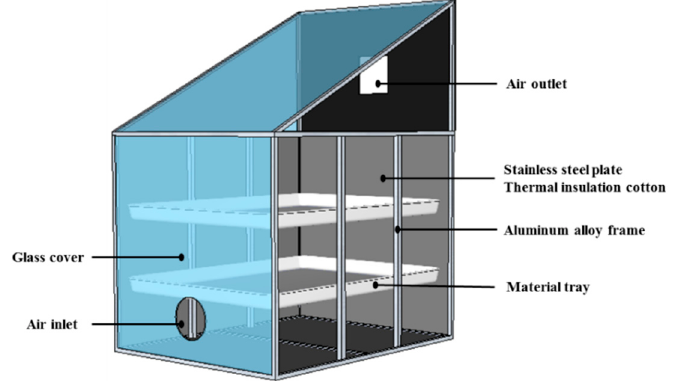
Figure 3. Schematic diagram of drying chamber.